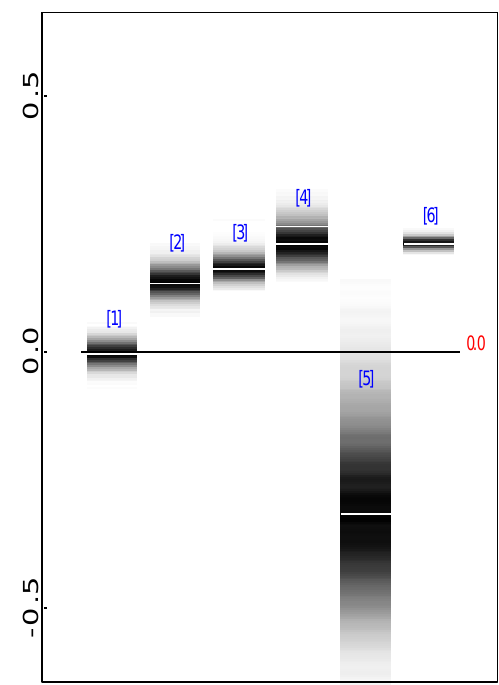
Figure 2. Density strips of the posterior distribution of parameters: [1]= µ [4]= σ , [5]=Corr ( α, β ) , [6]= β